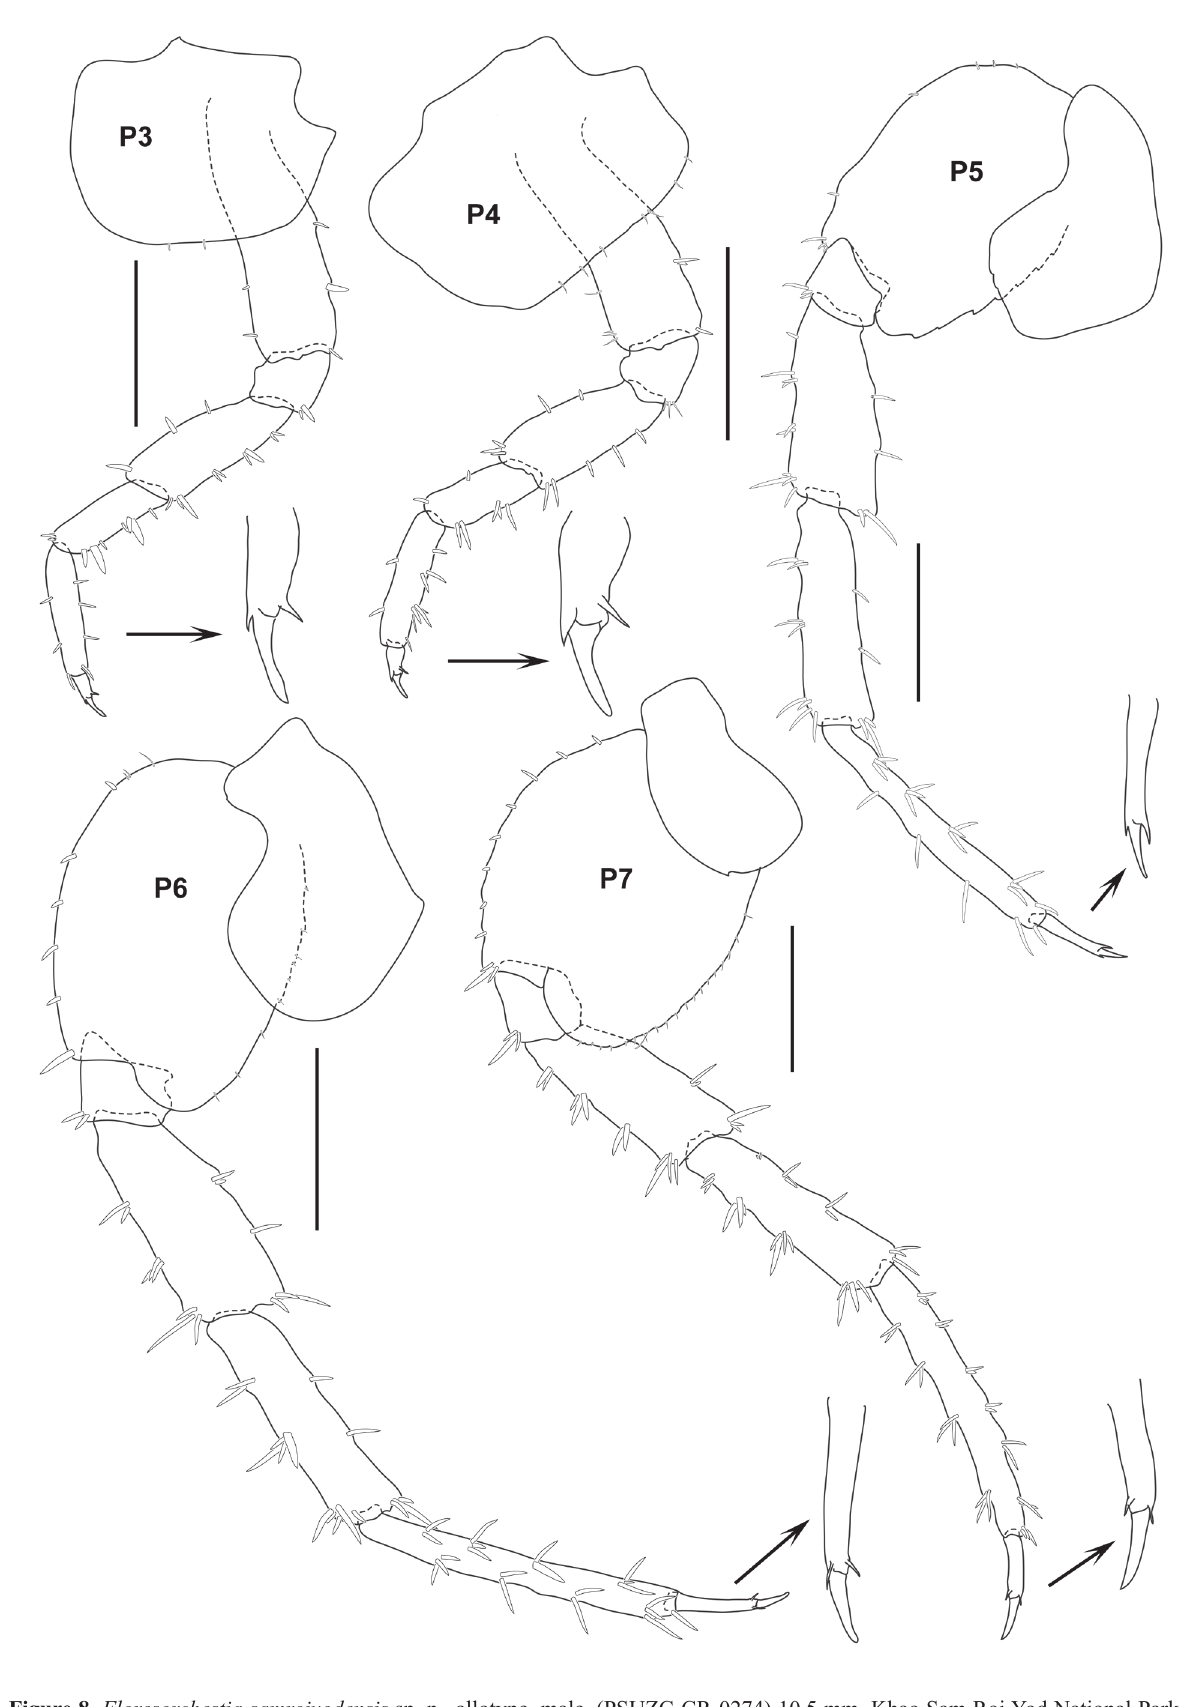
Figure 8. Floresorchestia samroiyodensis sp. n., allotype, male, (PSUZC-CR-0274) 10.5 mm. Khao Sam Roi Yod National Park. All scales represent 0.5